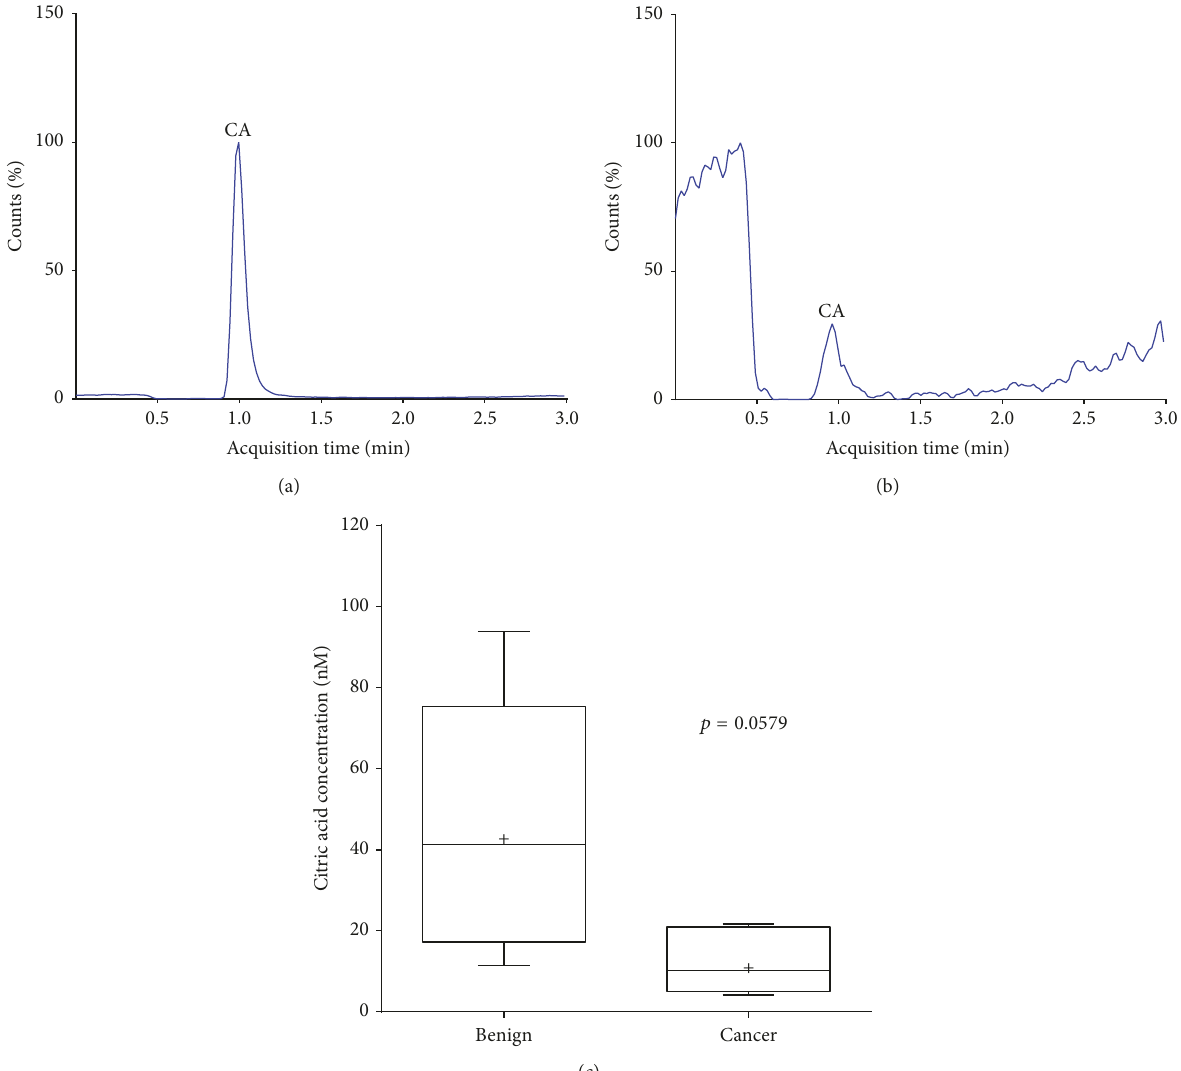
Figure 4: Identification and quantification of citric acid (CA) in human prostate tissue. (a) LC-MS/MS chromatogram of citric acid (CA) in benign tissue. (b) LC-MS/MS chromatogram of citric acid (CA) in cancer tissue. (c) Average concentrations (nM) of citric acid in benign and cancer tissue. Frozen tissue samples were ground to powder before subsequent extraction. Citric acid (nM) was quantified from benign ( 𝑛 = 5 ) and cancer ( 𝑛 = 5 ) prostate tissue samples using LC-MS/MS. The results are corrected for tissue weight. Mean values are shown as “+.” Statistical analysis was performed with Student’s 𝑡 -test ( 𝑝 = 0.0579